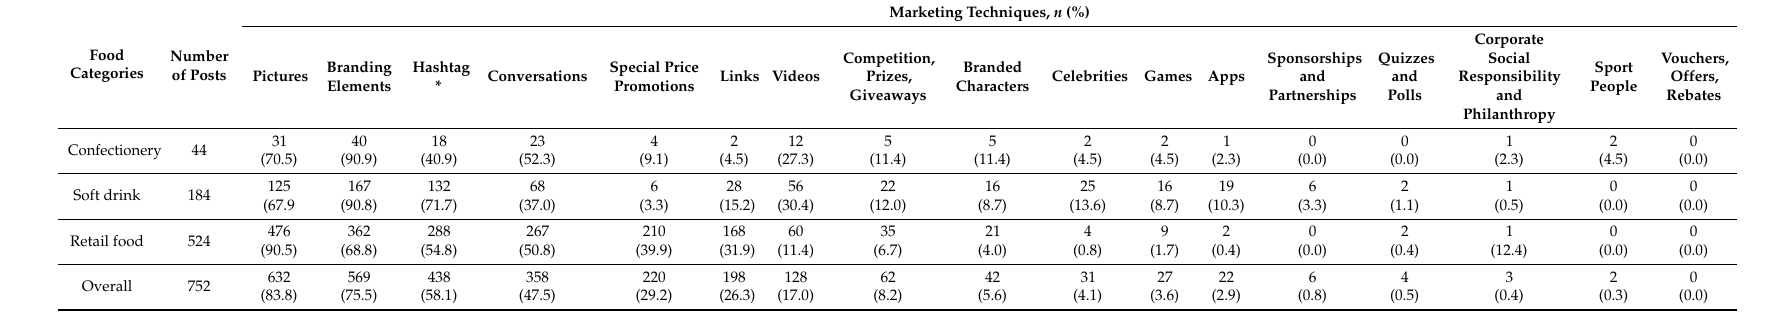
Table 3. Marketing techniques used by the Facebook pages, 1–31 December